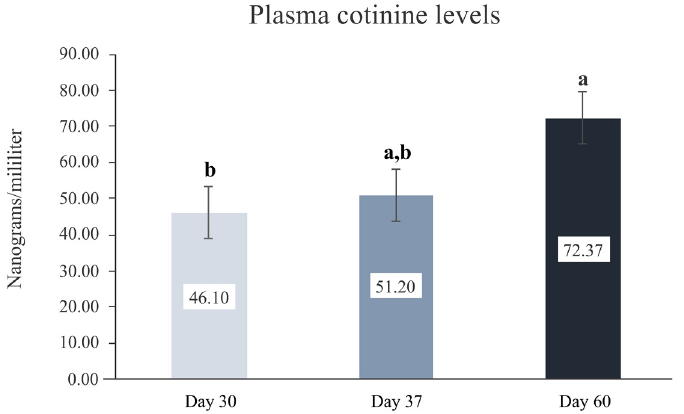
Figure 3. Plasma cotinine level of rats, in nanograms per milliliter, at different times after exposure to cigarette smoke. Mean values, error bars show 95% confidence interval. Different letters indicate statistically significant difference between groups.